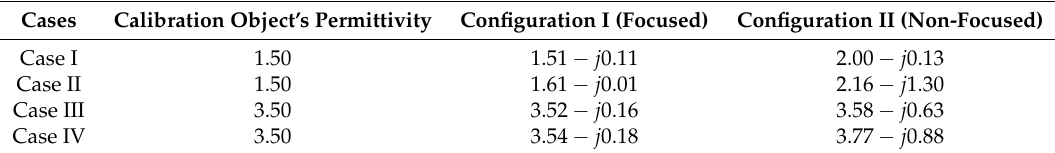
Table 2. The inversion results for Cases I to IV under the two configurations: with the Bessel beam (Configuration I) and the dipole antenna (Configuration